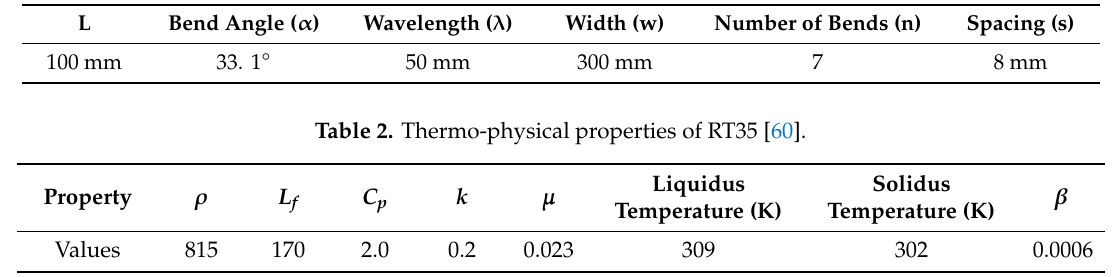
Table 1. Geometrical details of the zigzag mist eliminator.